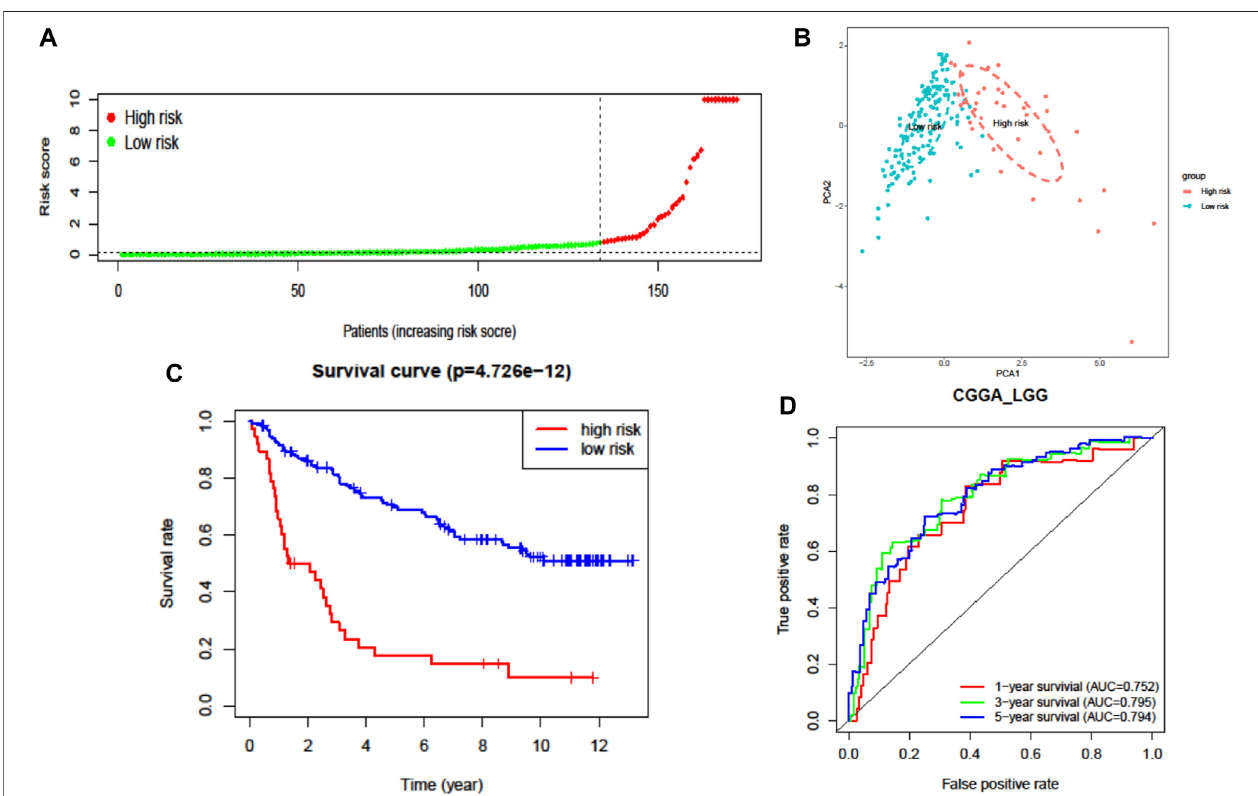
FIGURE4| Externalvalidationoftheseven-FRGsignaturemodelintheCGGAcohort( n (cid:1) 170). (A) Distributionoftheriskscores. (B) PCAplotoftheCGGAcohort. (C) Kaplan – Meier curves for the OS of patients in the high-risk group and low-risk group. (D) The AUC of time-dependent ROC curves veri fi ed the prognostic performance of the risk